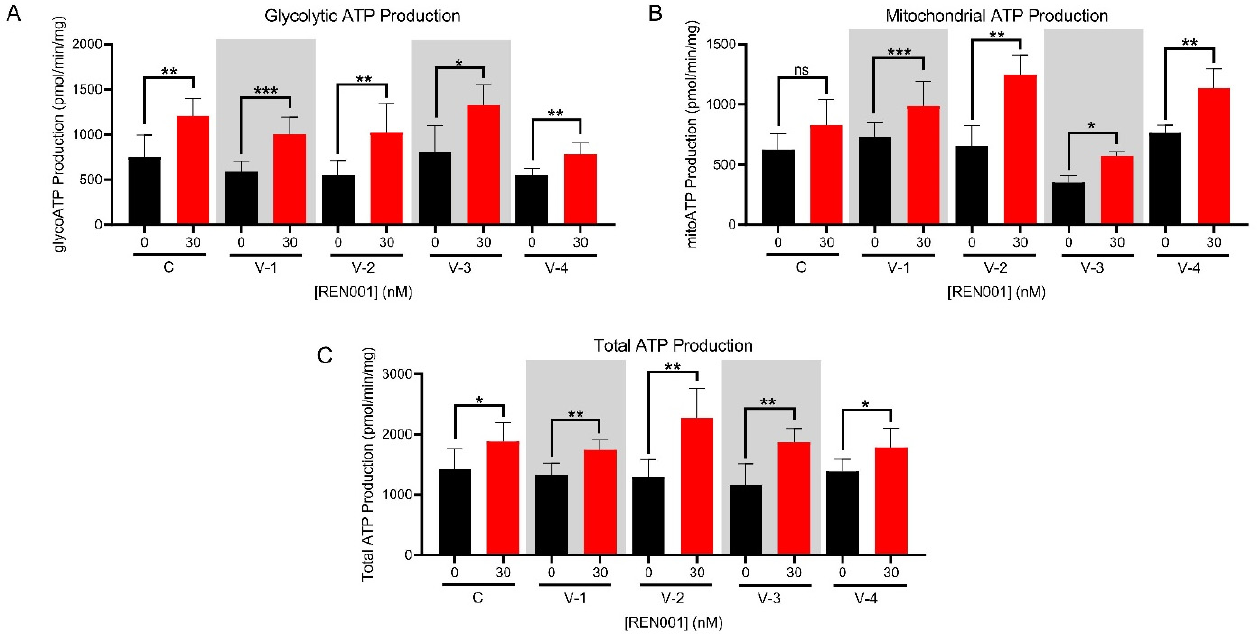
Figure 5. Real-time ATP production measured with Seahorse Bioanalyzer as described in the Meth- ods in control and VLCAD-deficient fibroblasts treated with REN001 for 48 h. ( A ). Glycolytic ATP production. ( B ). Mitochondrial ATP. ( C ). Total ATP production. Bars represent mean and standard deviations. * p < 0.05, ** p < 0.01, *** p < 0.001, ns = not significant, compared to values at 0 nM treatment (n = 6 for all assays; t -test for unpaired samples).